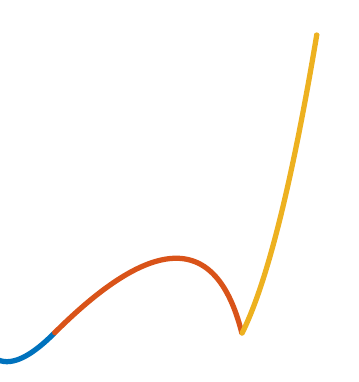
Figure 3. Graphical illustration of the C 0 and G 1 continuities: the curves in blue and red are connected with G 1 continuity; the curves in red and yellow are connected with C 0